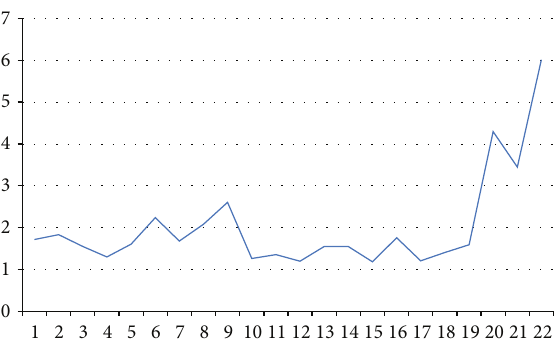
Figure 2: The ratio of SISEC CPU time to CG CPU time.